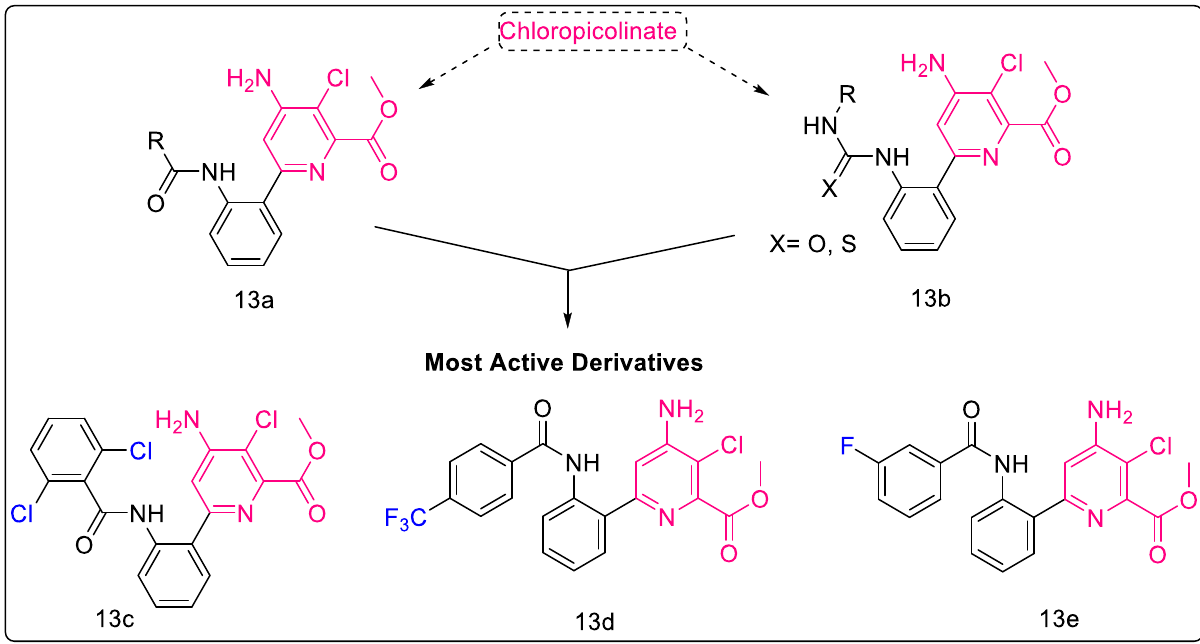
Figure 4. Chloropicolinate hybrids. ( 13a ) Amide analogs derived from chloropicolinate. ( 13b ) Urea and thiourea analogs derived from chloropicolinate. ( 13c ) o-Dichloro benzamide derivative. ( 13d ) p-Trifluoromethyl benzamide derivative. ( 13e ) m-Fluroro benzamide derivative.